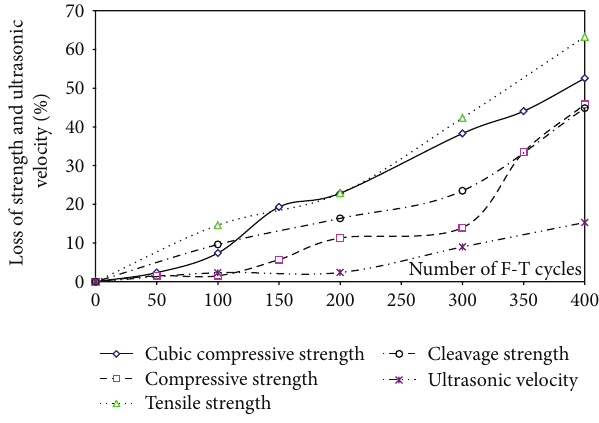
Figure 4: The loss of strength and ultrasonic velocity of A-E-C versus number of F-T